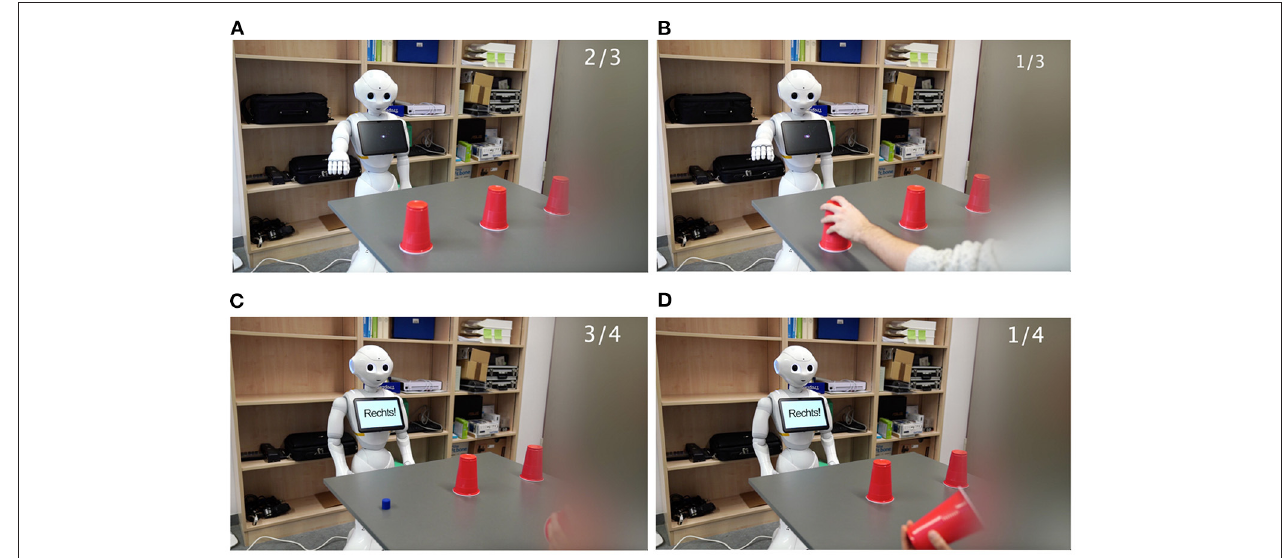
FIGURE 1 | Screenshots of the videos in Study 1, displaying HRI during a shell game in the conditions (A) anthropomorphism high x competence high, (B) anthropomorphism high x competence low, (C) anthropomorphism low, competence high, and (D) anthropomorphism low, competence low. Game scores are presented in the upper right corner of each